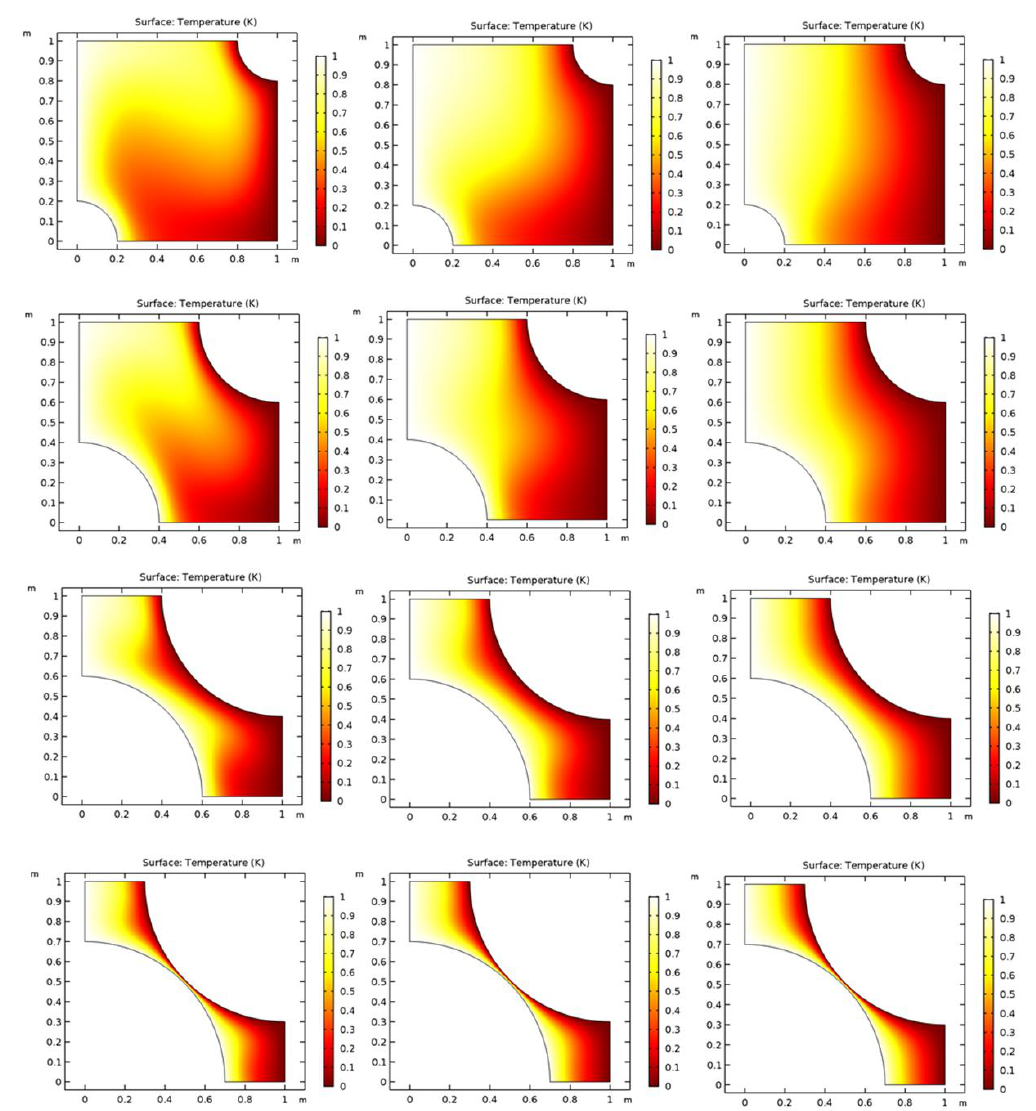
Figure 8. E ff ect of Hartmann number and round corner radius on the surface temperature Figure 8. Effect of Hartmann number and round corner radius on the surface temperature distribution.